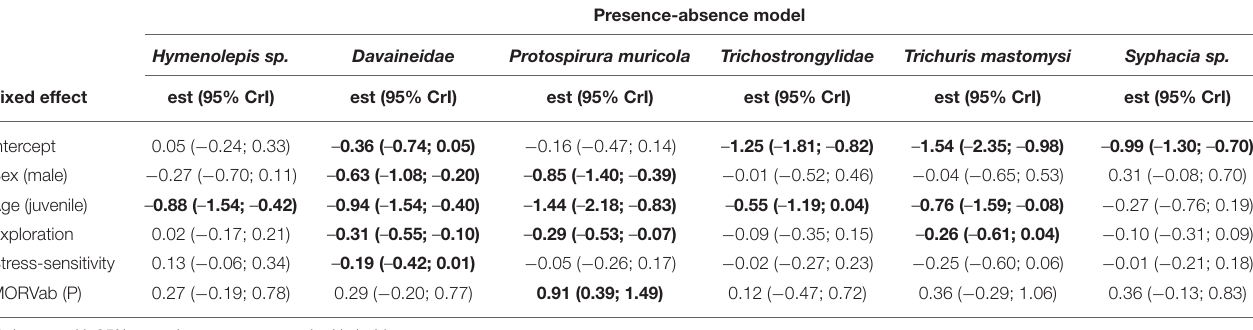
TABLE 2 | Posterior mean responses (with their 95% credibility intervals) of the different helminth species to the fixed effects derived from the presence-absence model.